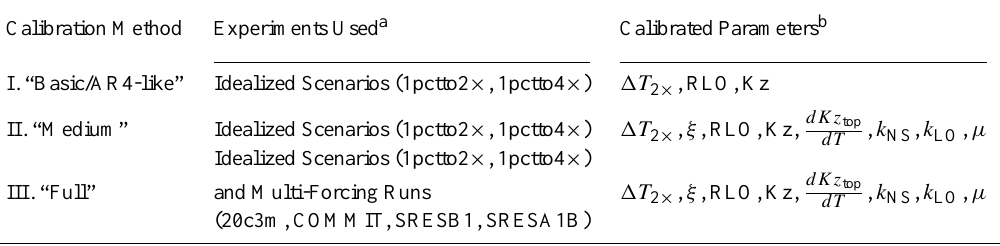
Table 1. Overview of calibration exercises. The hemispheric land and ocean surface air temperatures and ocean heat uptake were used for each